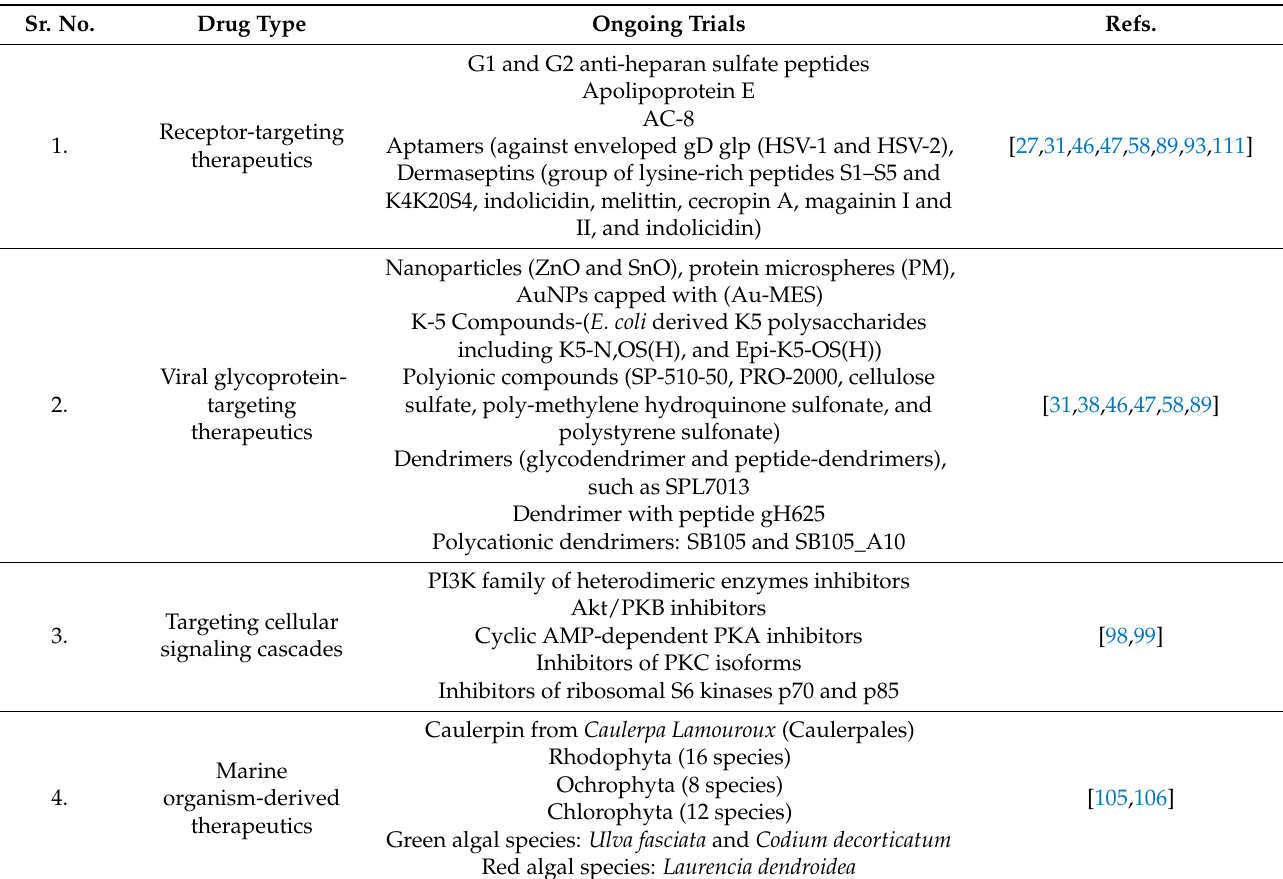
Table 2. Ongoing trials for HSV